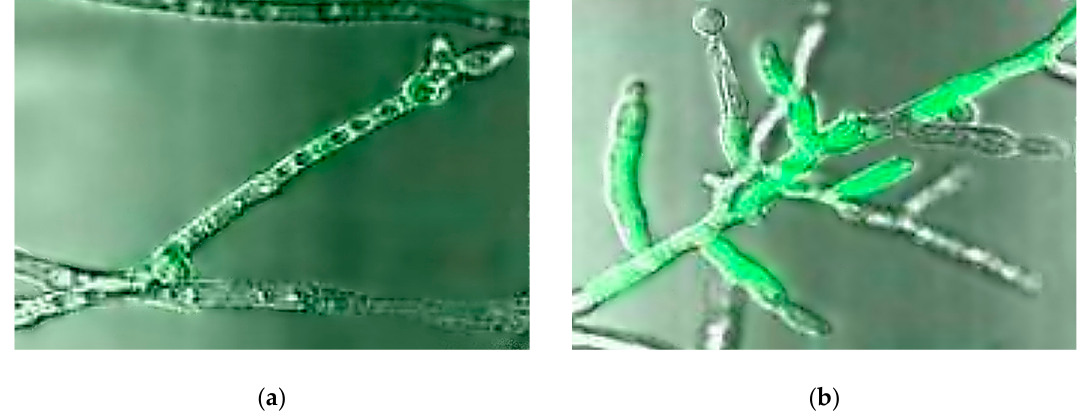
Figure 21. Confocal laser scanning microscopy (CLSM) image of F. oxysporum mycelium showing ROS production level upon exposure of chitosan BNMs. ( a ) control; ( b ) chitosan BNMs (400 µg/mL) ( modified after [84] ).